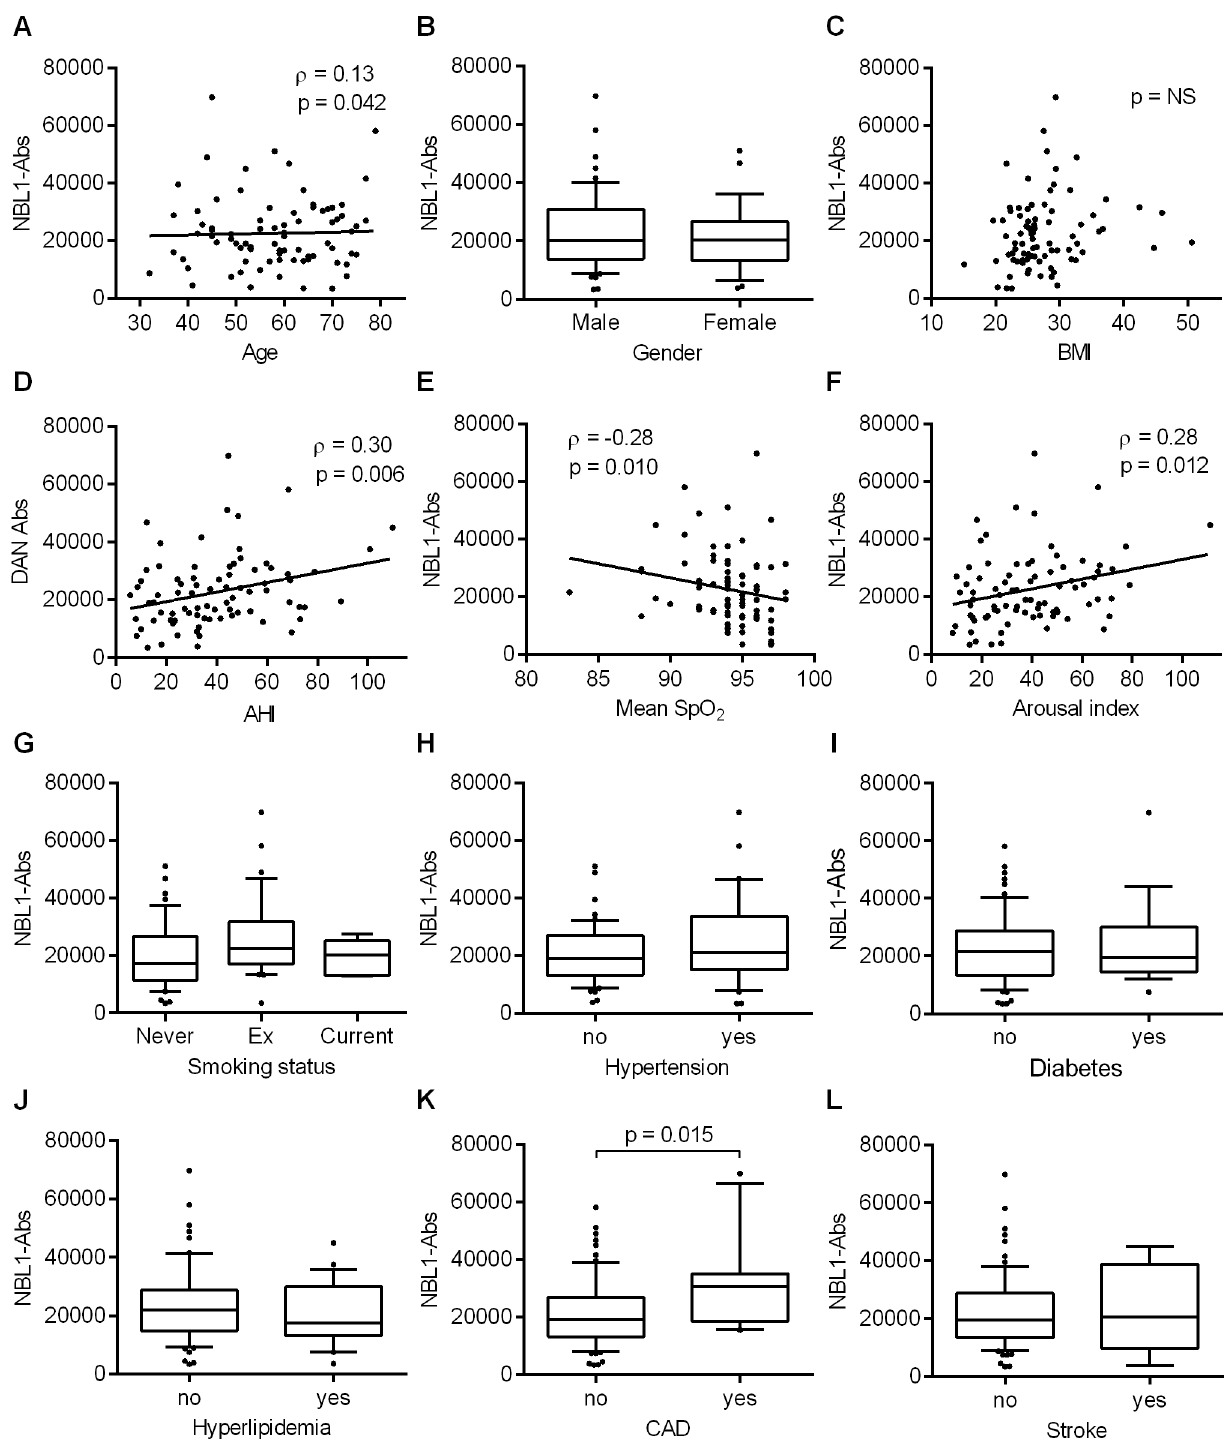
Fig 2. Association of NBL1-Ab with clinical parameters in patients with OSA. Correlations between NBL1-Abs and age (A), gender (B), BMI (C), AHI (D), mean SpO 2 (E), arousal index (F), smoking status (G), hypertension (H), diabetes (I), hyperlipidemia (J), CAD (K), and stroke (L) were evaluated. Weak associations were observed between NBL1-Ab levels and age, AHI, mean SpO 2 and arousal index. OSA patients with CAD had significantly higher NBL1-Ab levels than OSA patients without CAD. Spearman’s correlation analysis (A, C—F), Mann—Whitney U test (B, H-L) and Kruskal—Wallis test (G) were used. Horizontal lines represent medians, boxes represent the 25th and 75th percentiles, whiskers represent the 10th and 90th percentiles and dots represent outliers. AHI, apnea-hypopnea index; BMI, body mass index; CAD, coronary artery disease; NBL1-Abs, autoantibodies against NBL1; OSA, obstructive sleep apnea.